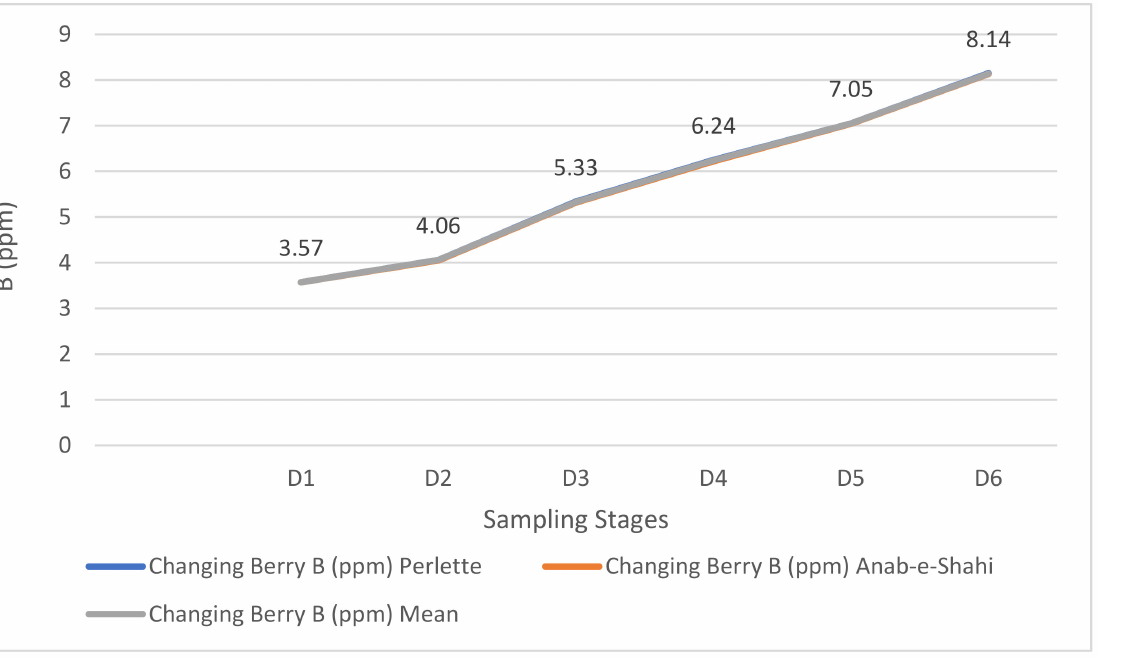
Figure 9. Dynamics of Boron (ppm) during the development of berries in grapes, cv. Perlette and